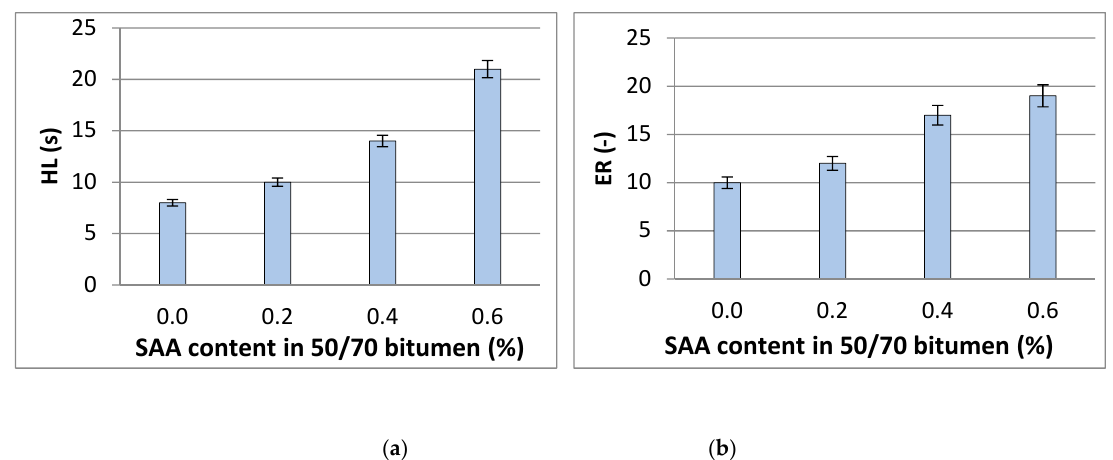
Figure 8. Average values of foaming parameters of 50 / 70 bitumen with additives, a ) half-life–HL, b ) maximum expansion–ER (error bars represent standard deviation).